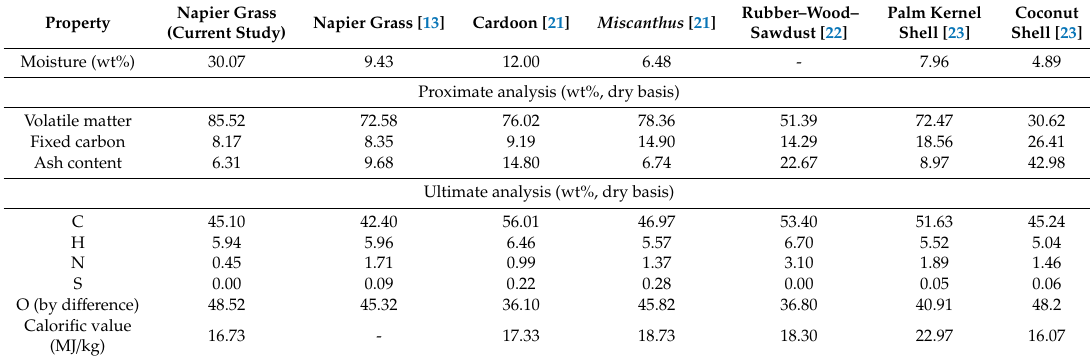
Table 2. Comparison of Napier grass (NG) feedstock characteristics with various types of biomass in